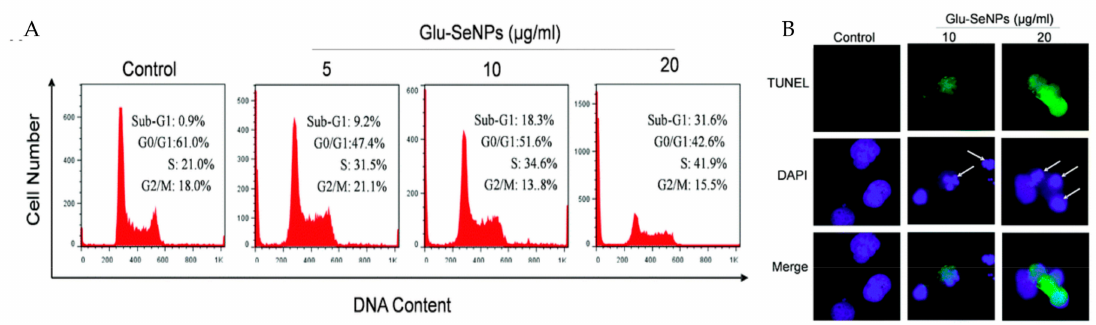
Figure 5. Apoptosis induced by Glu-SeNPs in cancer cells: ( A ) flow cytometric analysis of cancers cells; and ( B ) DNA fragmentation and nuclear condensation. Reproduced with permission